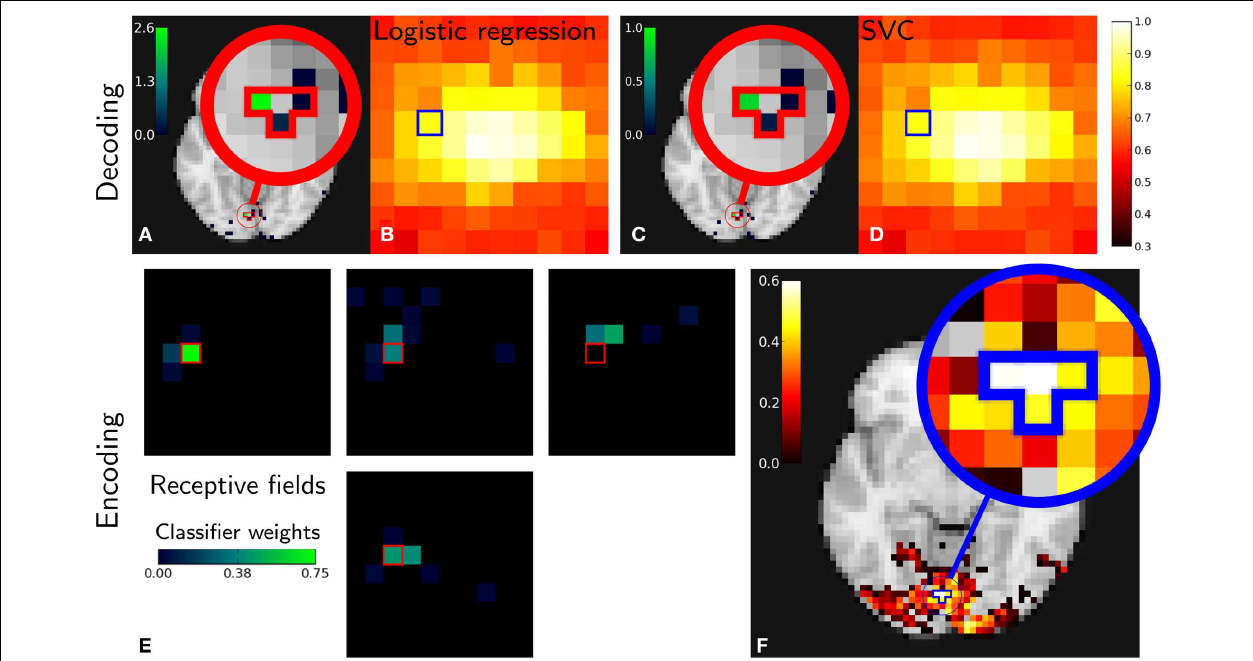
FIGURE 3 | Miyawaki results in both decoding and encoding. Relations between one pixel and four brain voxels is highlighted for both methods. Top: Decoding. Classifier weights for the pixel highlighted [ (A) Logistic regression, (C) SVM]. Reconstruction accuracy per pixel [ (B) Logistic regression, (D) SVM]. Bottom: Encoding. (E) : receptive fields corresponding